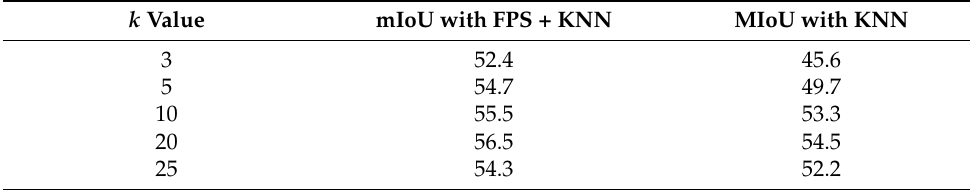
Table 3. Performances for the feature encoding models with different k values.